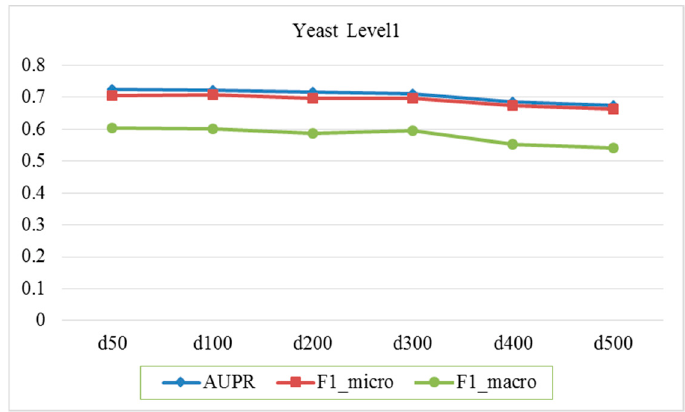
Figure 1. Performance comparison under different network feature dimensions.